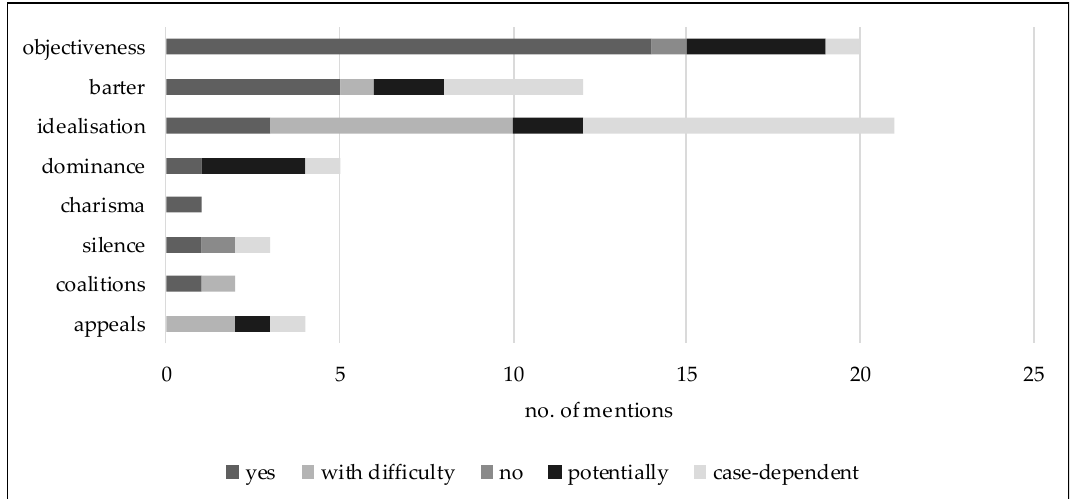
Figure 4. The success of power tactics by science managers.